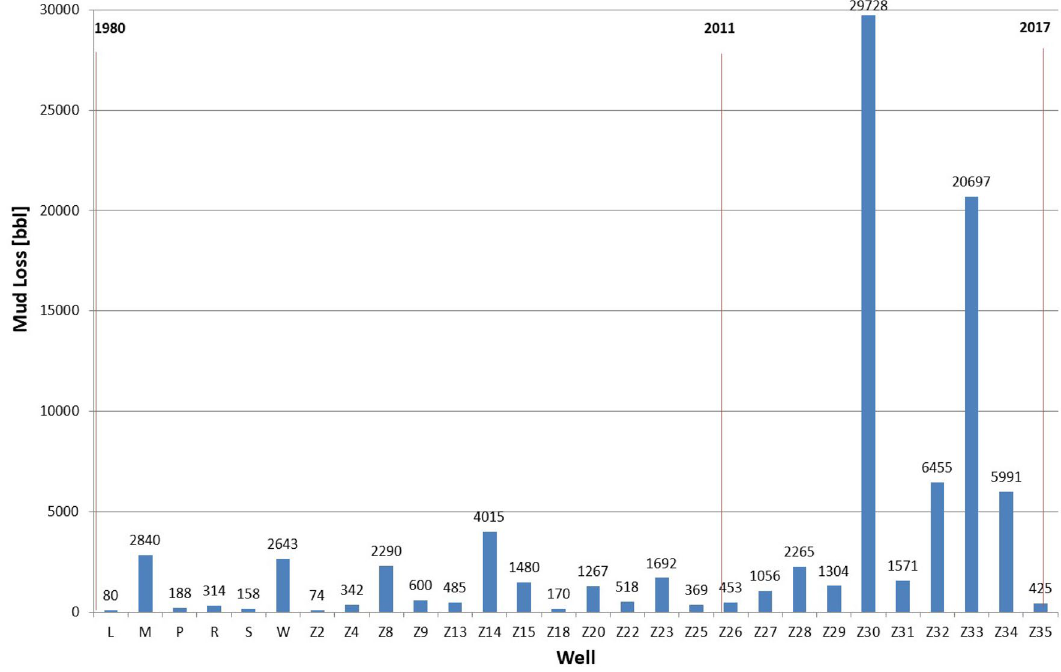
Fig. 2 Mud loss magnitudes occurring in Gachsaran formation in different wells of Kupal